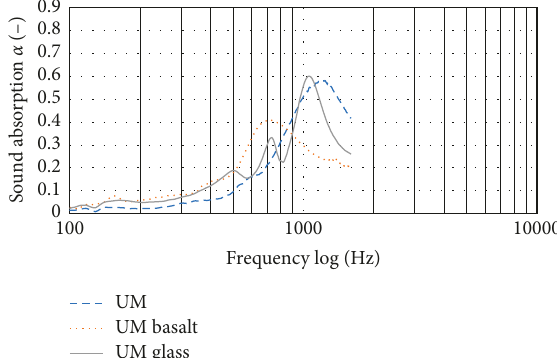
Figure 14: Obtained absorption coefficient values for the Thermo UM plaster.